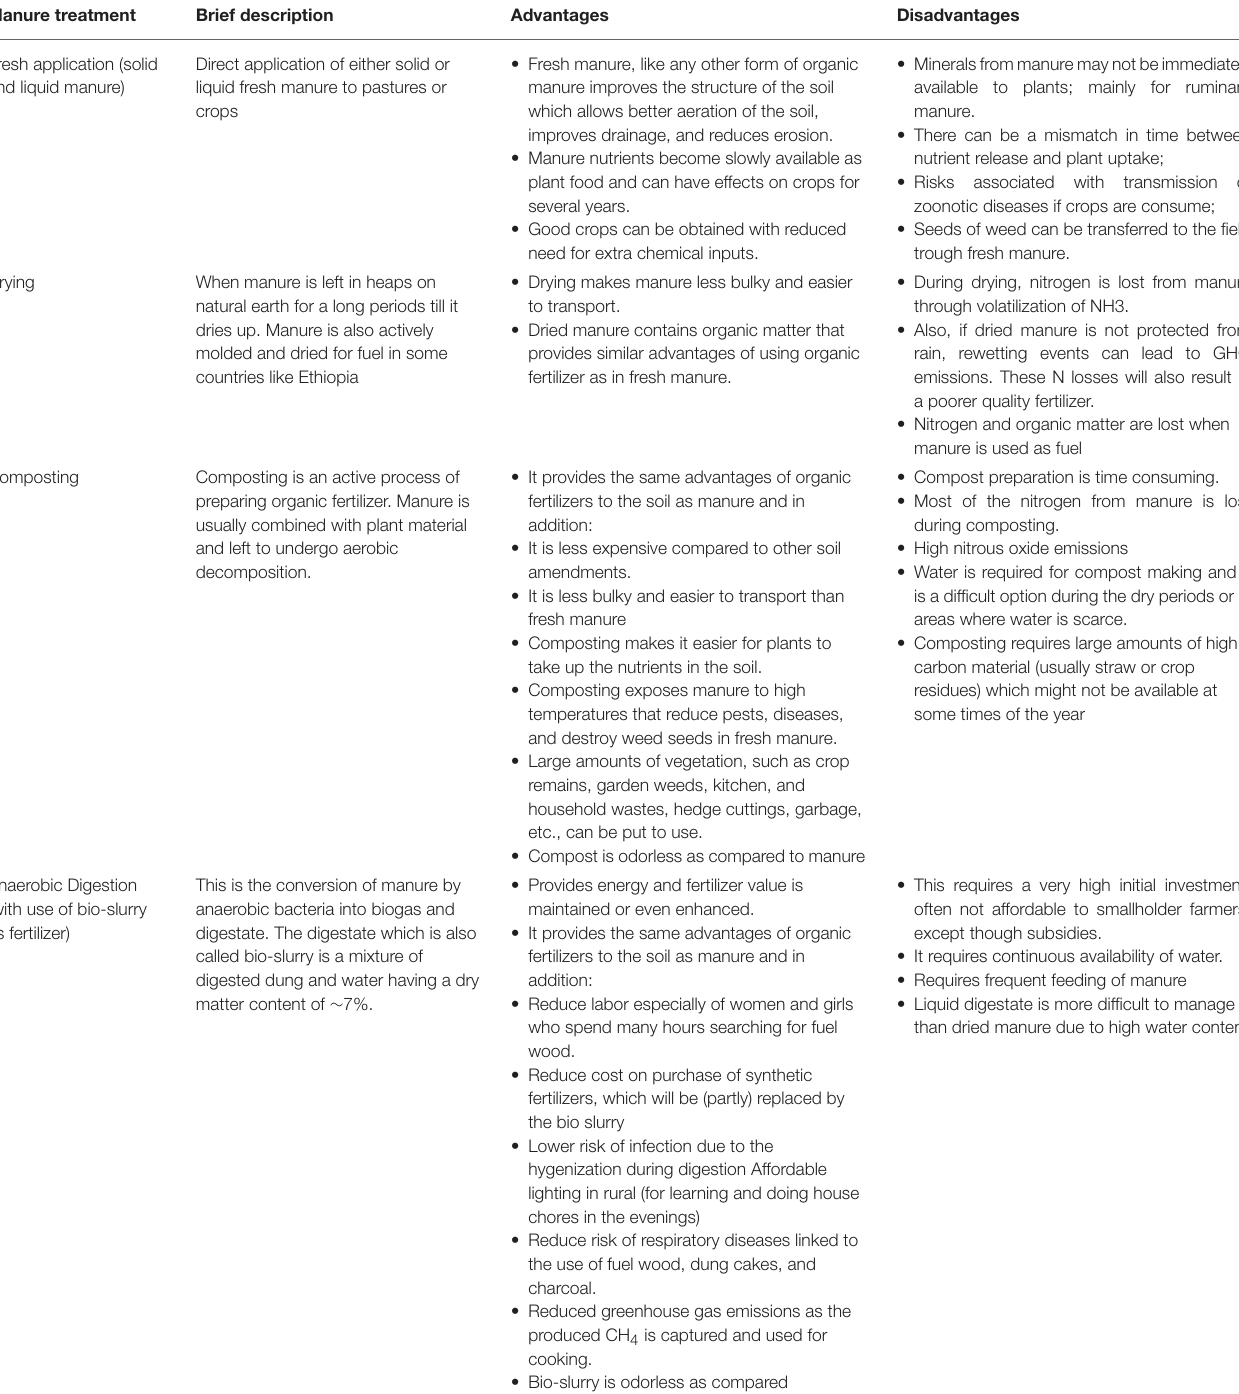
TABLE 5 | Summary of advantages and disadvantages of major manure management options in SSA. Manure